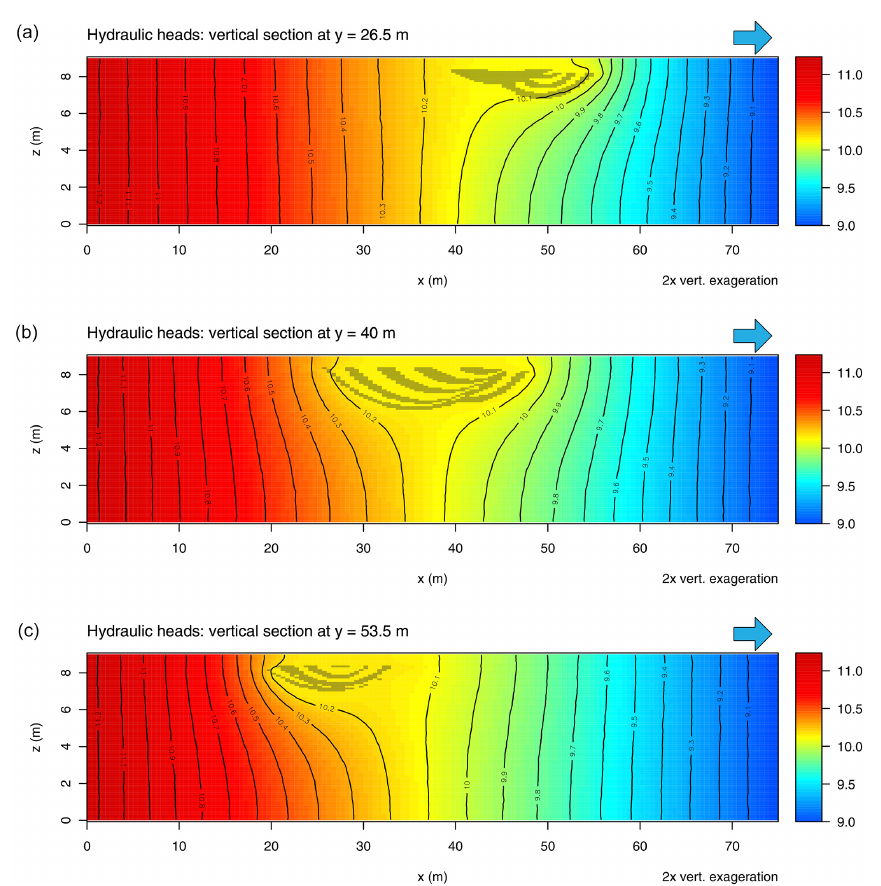
Figure 6. Cross sections of the hydrogeological model along the x axis (see the coordinate system defined in Fig. 5a) with hydraulic head contours (every 0.2m) superimposed on the hydraulic head values. The blue arrows indicate the main flow direction. The grey pixels correspond to the highly permeable layers of open-framework gravels.